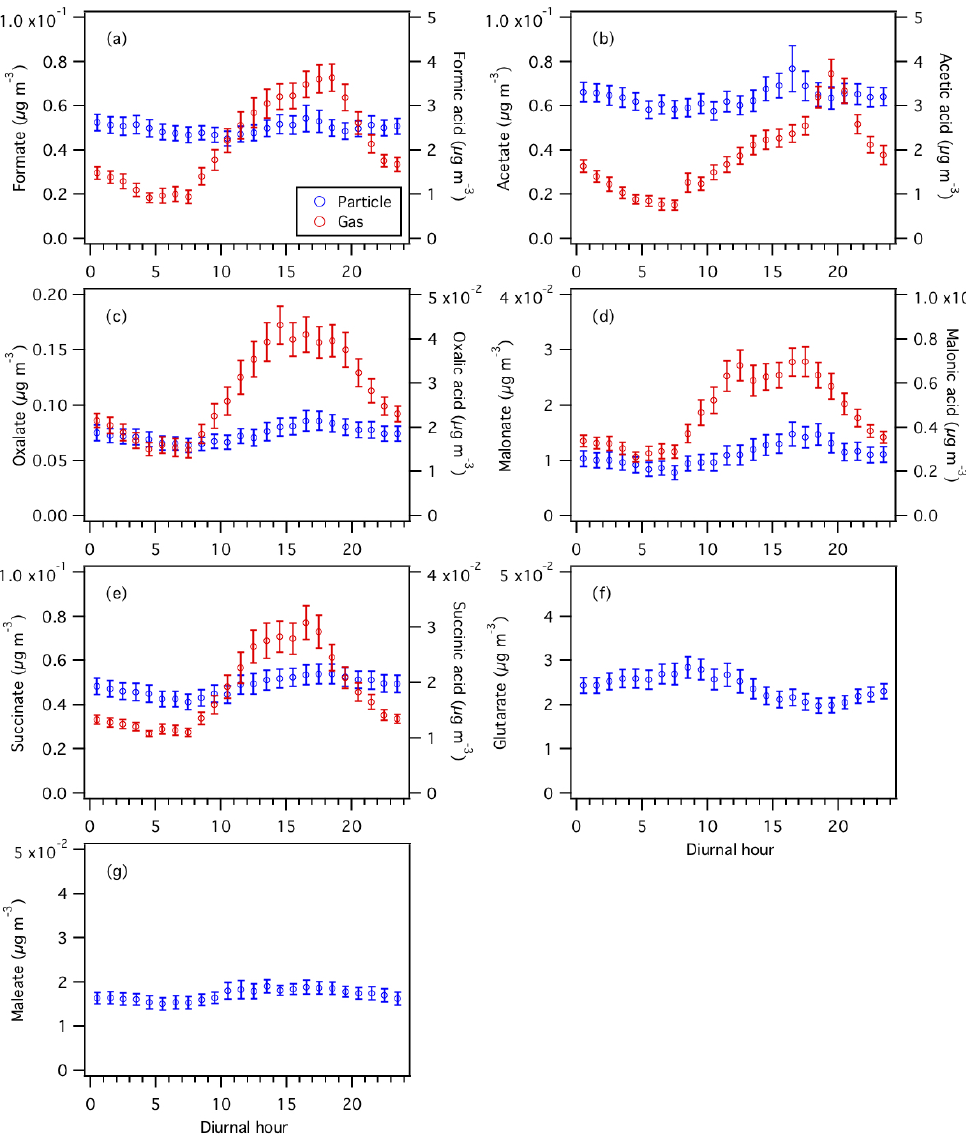
Figure 6. Diurnal profiles of particle- and gas-phase (a) formic, (b) acetic, (c) oxalic, (d) malonic, (e) succinic, (f) glutaric, and (g) maleic acids. Particle-phase measurements are shown on the left y axes, while gas-phase measurements are shown on the right y axes. All the data shown here represent averages in 1h intervals. Error bars shown are the standard